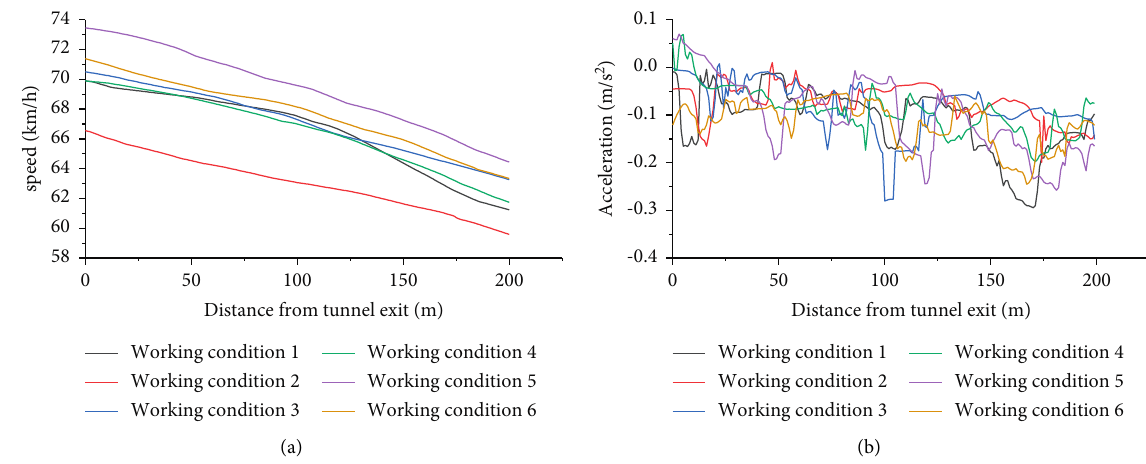
Figure 8: Vehicle speed and acceleration curves within 200m after the tunnel exit in the second service level. (a) Speed curve (b) Ac- celeration curve.